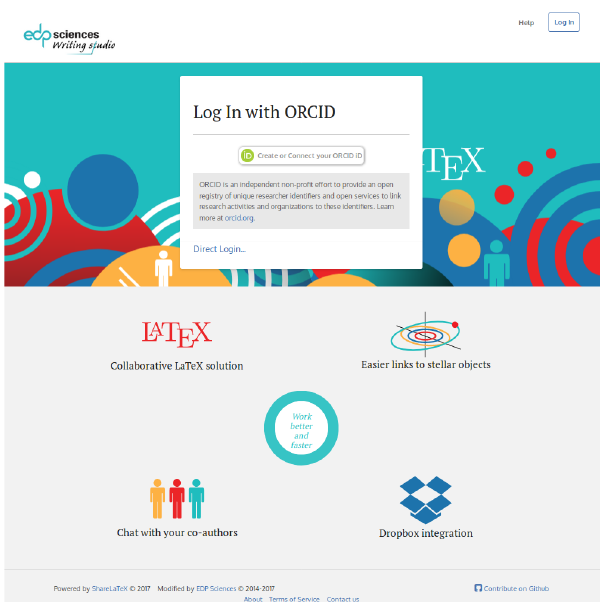
Figure 5. Login page for the Scientific Writing